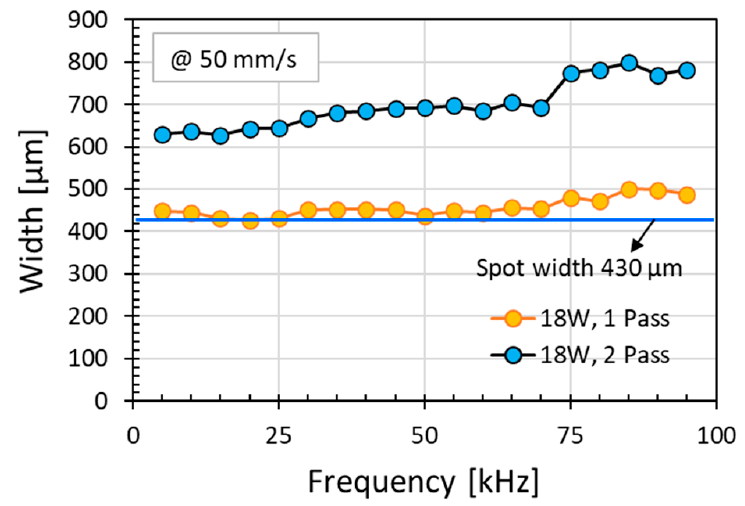
Figure 7. Scanning line width under various energy dose per unit length per pass for one or two tively).